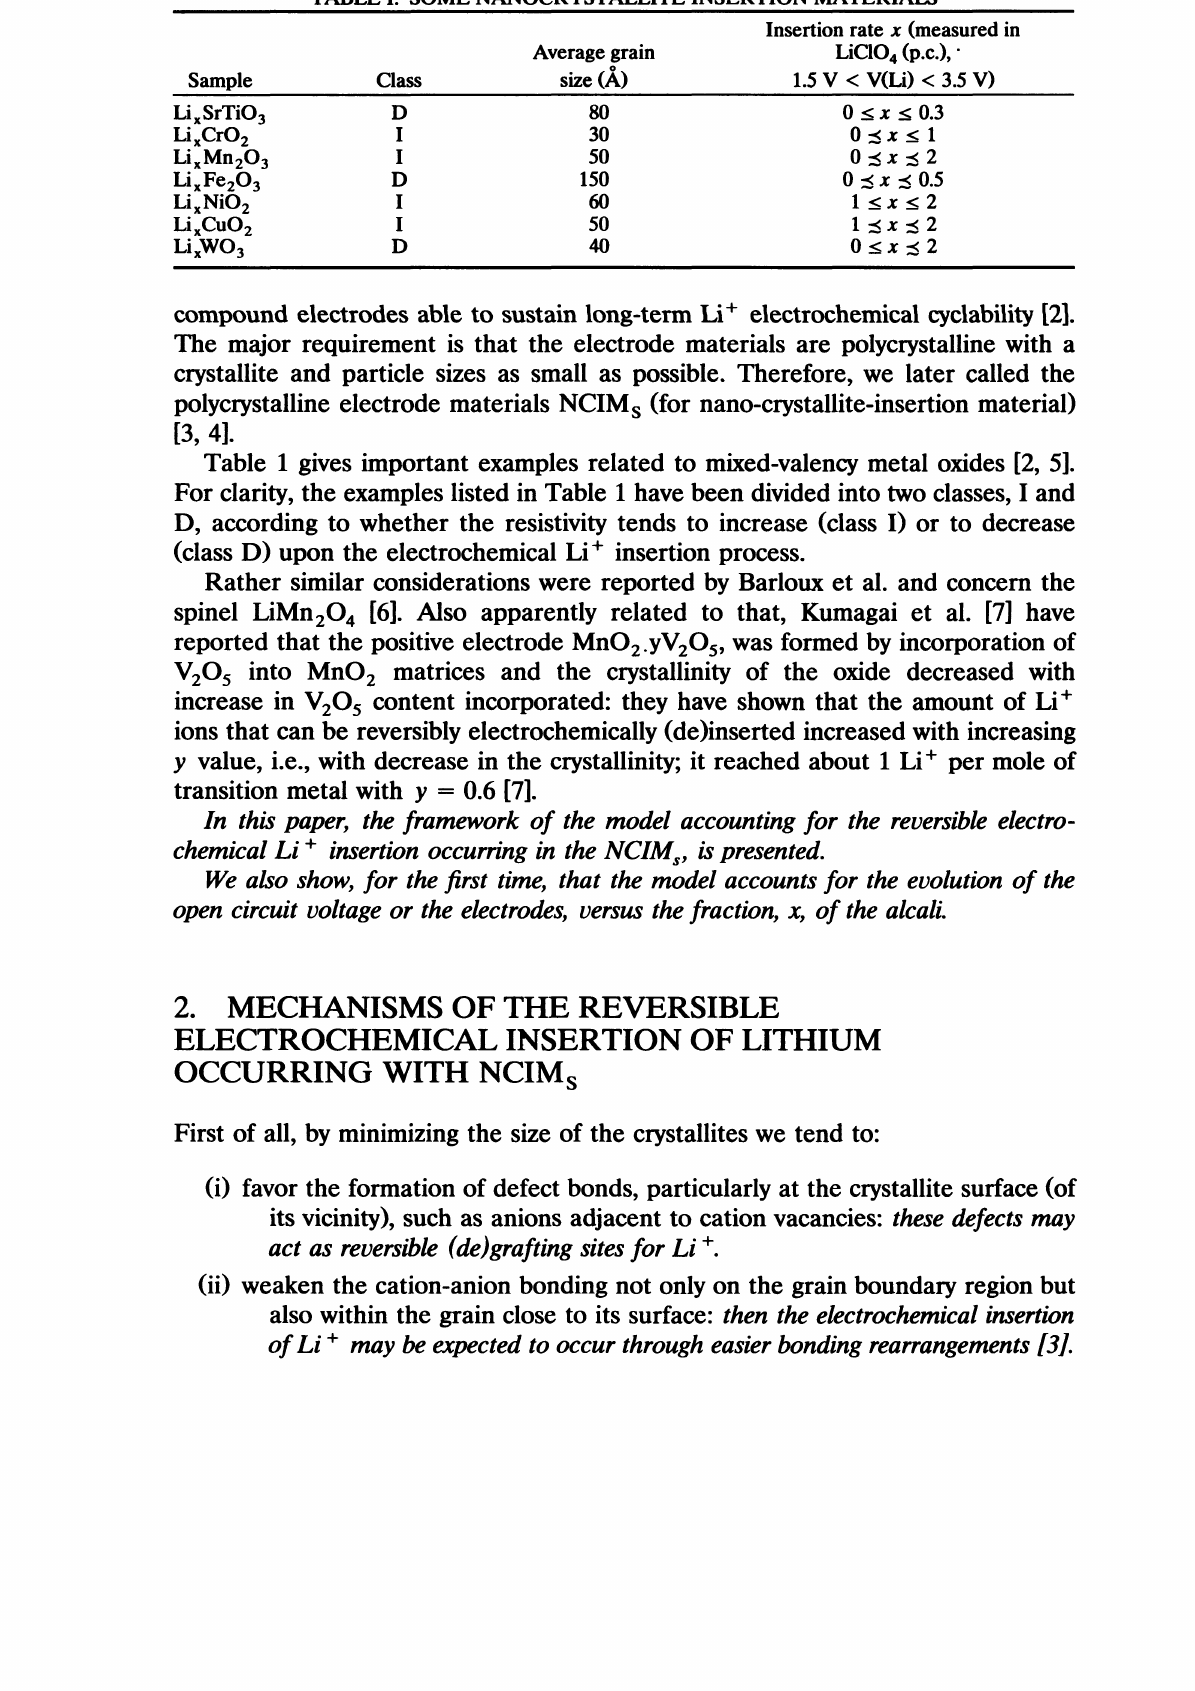
TABLE I. SOME NANOCRYSTALLITE INSERTION